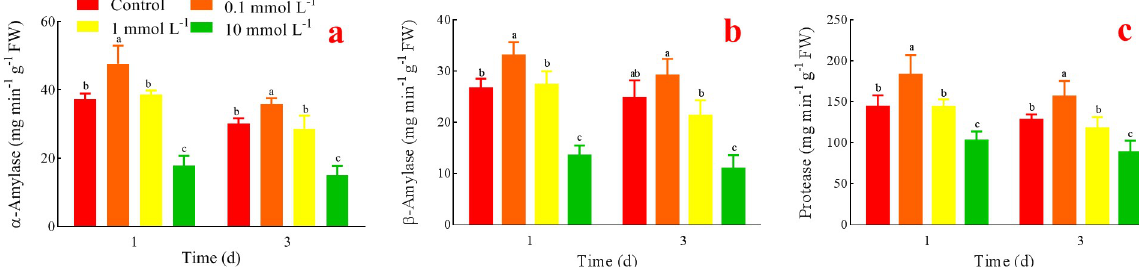
Fig 2. Effects of AsA on α -amylase (a), β -amylase (b), and protease (c).